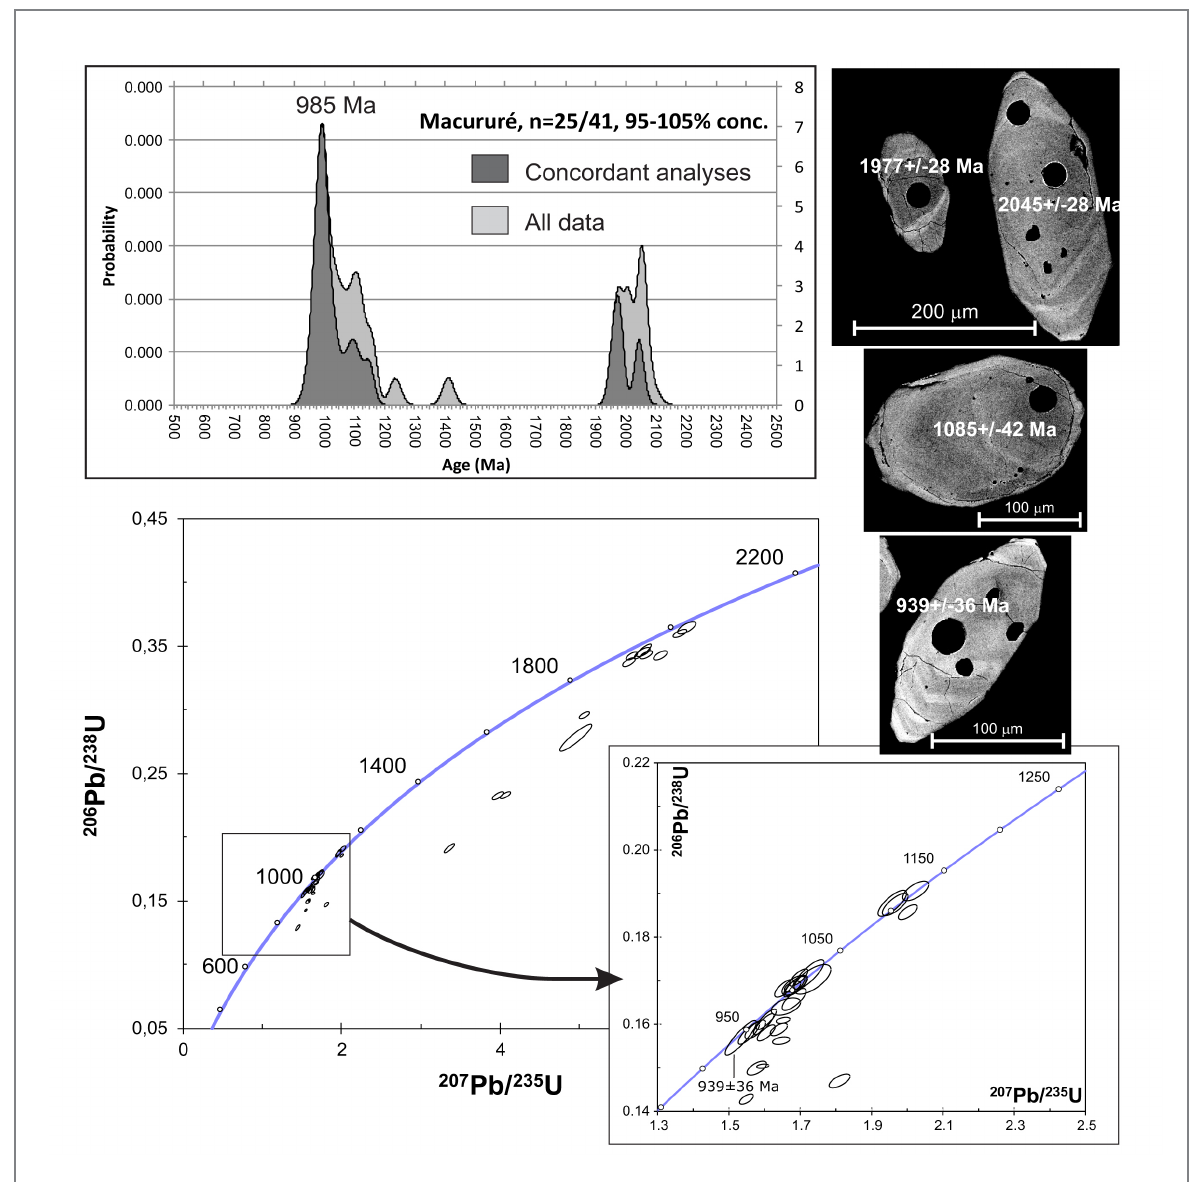
Figure 5 - Probability and Concordia plots for LA-ICP-MS zircon analyses from sample MAC-02 and representative backscattered electron (BSE) images of analyzed